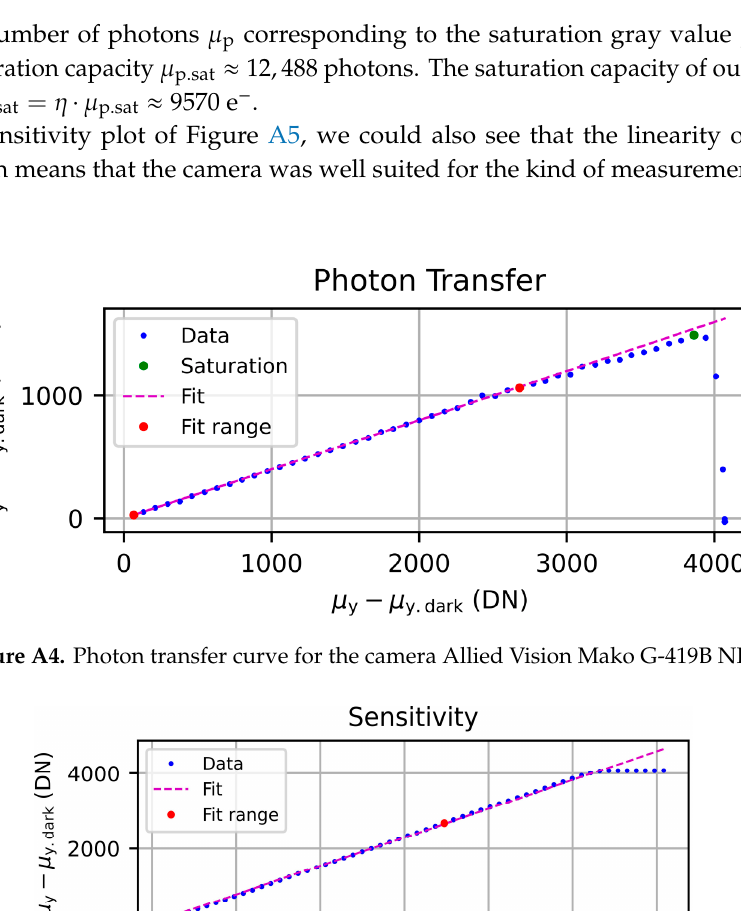
Table A9. Settings of the FRED software parameters for the stray light simulation.